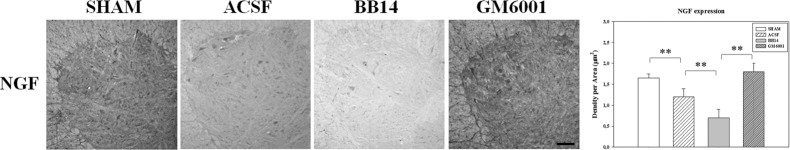
Endogenous NGF expression in the ventral horn.(A) Sections of lumbar spinal cord prepared from SHAM and SNI rats treated for 7 days with ACSF (vehicle), BB14 (0.9 mg/kg b.w.), or GM6001 (100 mg/kg. b.w.) and immunostained with NGF antibody. Scale bar: 50 μm. (B) Densitometric quantitation of NGF levels. Data are the mean±SEM (**p≤0.001, ACSF vs. SHAM/BB14/GM6001; ANOVA and Holm–Sidak test). Scale bar: 50 μm.